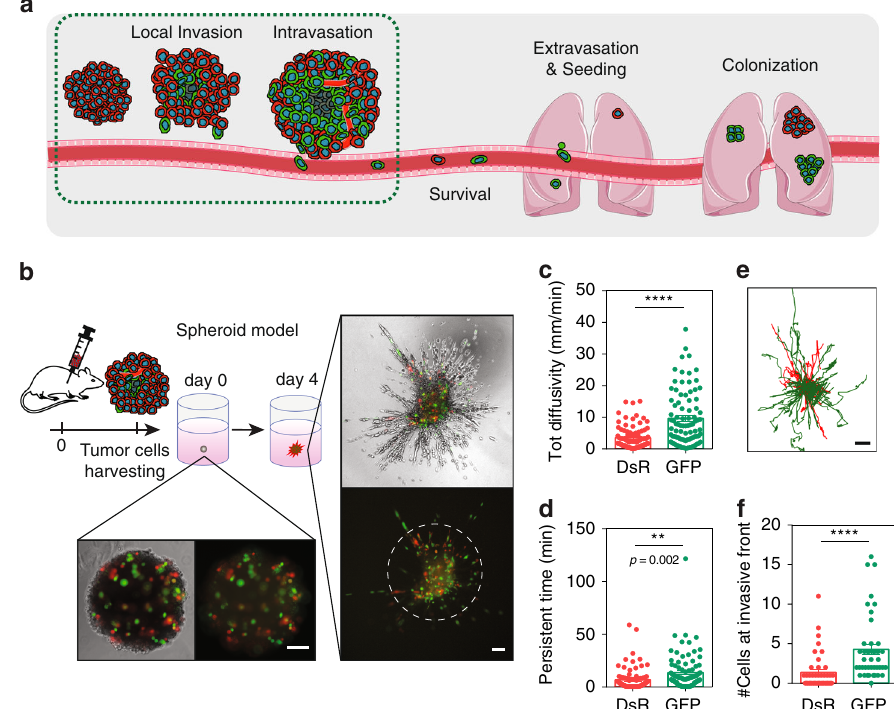
Fig. 7 Exposure to intratumoral hypoxia promotes invasion. a Schematic representation of the early and late steps of the metastatic cascade. b Tumor- derived cells were incorporated with 90% non-labeled wild-type MDA-MB-231 cells in a 3D spheroid fully embedded in collagen. After 4 days in culture, spheroids were subjected to time-lapse imaging every 5 min for 16 h. Phase-contrast and fl uorescent images taken on days 0 and 4 of the same spheroid. Scale bar = 100 μ m. The white dashed ring marks the invasive front of the spheroid. c , d Total diffusivity (mm/min) ( c ) and persistent time (min) ( d ) of DsRed + and GFP + (mean ± SEM, N = 3, n = 80 – 92 cells); **** P < 0.0001 GFP versus DsRed (two-tailed t -test). e Projection of DsRed + (red) or GFP + (green) cell trajectories. Scale bar = 100 μ m. f Number of DsRed + and GFP + cells at the invasive front of the spheroid (beyond the dashed white line in ( b )) (mean ± SEM, N = 3, n = 44 spheroids); **** P < 0.0001 GFP versus DsRed (two-tailed t (Supplementary Fig. 12a, b and Supplementary table 7). The Hallmark ROS pathway was no longer enriched in DsRed + cells (Supplementary Fig. 12c and Supplementary Table 8).